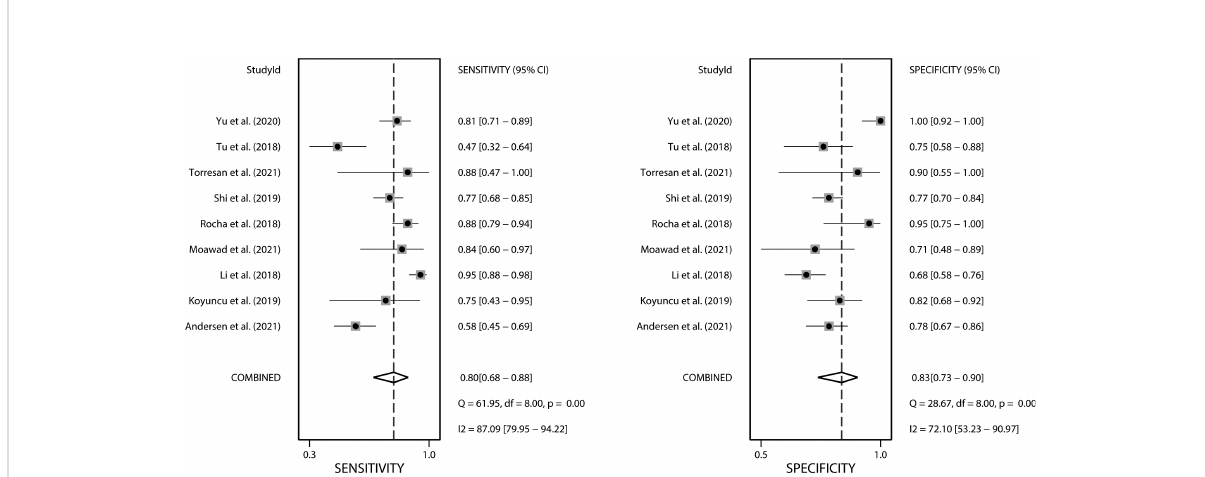
FIGURE 4 Forest plots of the sensitivity and speci fi city of CT-based radiomics in differentiating malignant from benign adrenal tumors. I 2 >50% indicates substantial heterogeneity among included